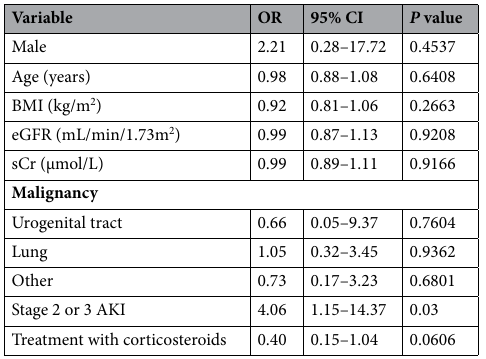
Table 4. Risk factors for nonrecovery of renal function in AKI patients (multivariate logistic regression analysis).